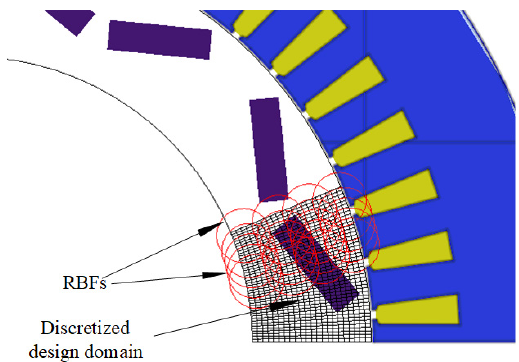
Figure 2. The initial discretized design domain and RBFs used to model it (in red).